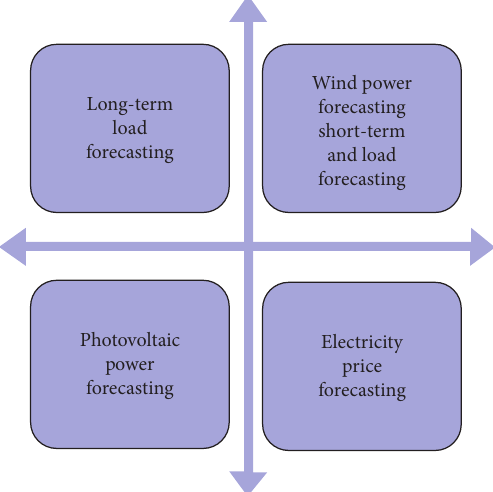
Figure 1: Development flowchart of different energy forecasts [5].